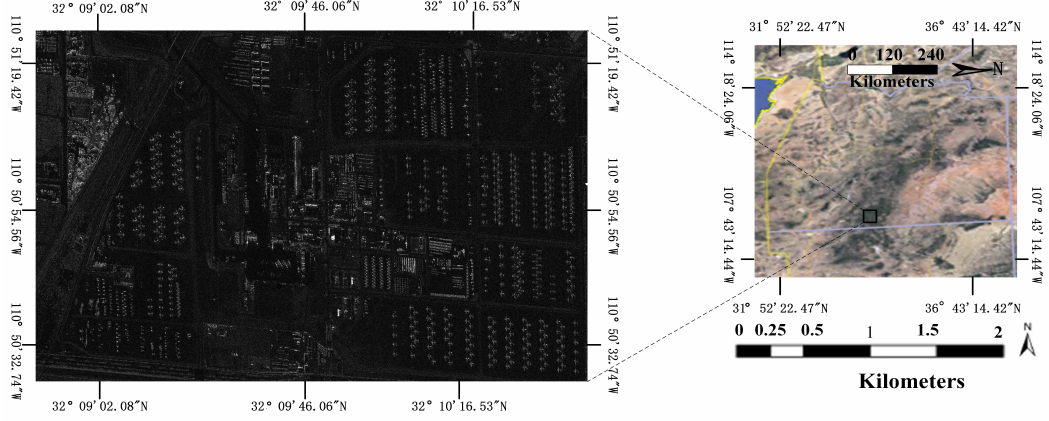
Figure 5. TerraSAR-X data adopted in our